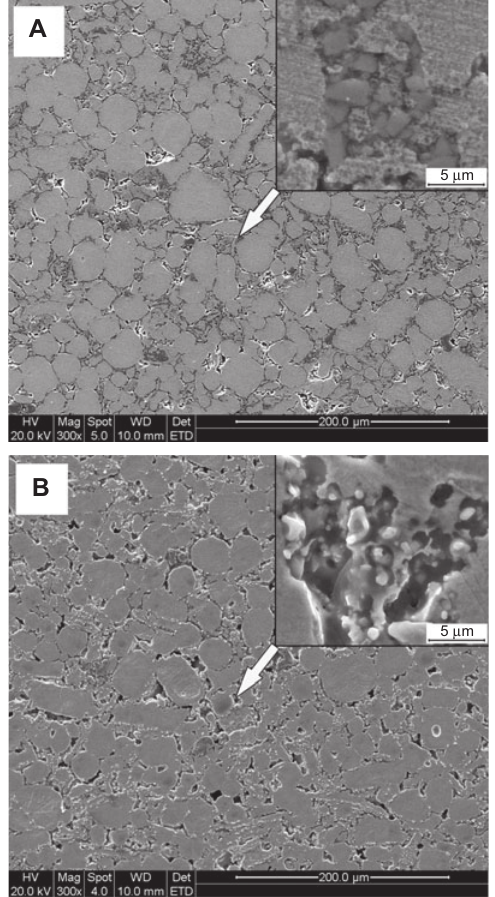
Figure 1 SEM of TiC/316L composites: (A) prepared by conventional PM technique; (B) prepared by